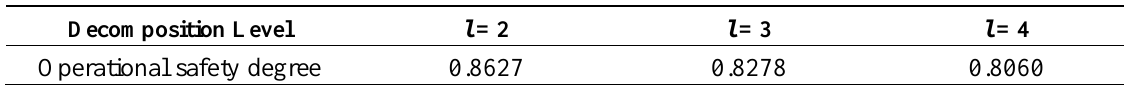
Table 2. The operational safety degree before maintenance from sensor-dependent vibration signals after